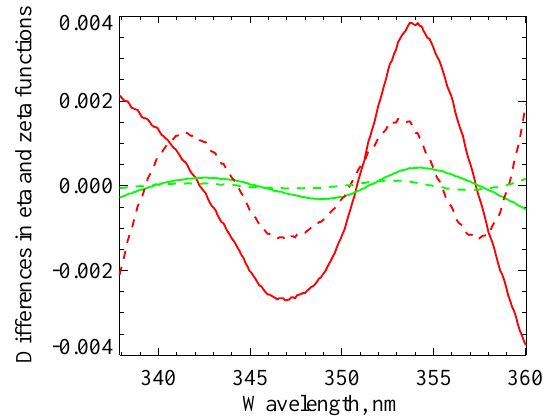
Fig. 3. Differential logarithmic eta (red) and zeta (green) functions. The functions are obtained as the spectral residuals remaining when fitting to each other the logarithms of the eta or zeta functions for different positions of the elevation scan mirror. The fit procedure in- cludes the scaling factor and a linear (solid lines) or a cubic (dashed lined)